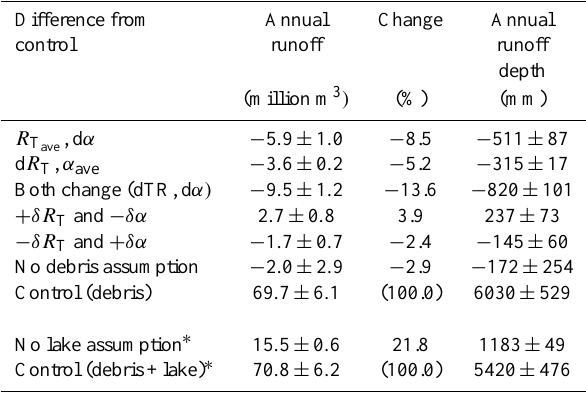
Table 3. Uncertainty in runoff due to thermal resistance ( R T ) and albedo ( α ), and topographical assumptions of the debris-covered area of the Trambau Glacier. Influences are obtained by averaging anomalies from positive and negative cases (Eq. 33 in Sect. 4.1). Combinations of changes in both parameters in different directions were also tested ( + δR T and − δα , − δR T and + δα ). Errors rep- resent interannual variability calculated for the period 1979–2007 (28years).